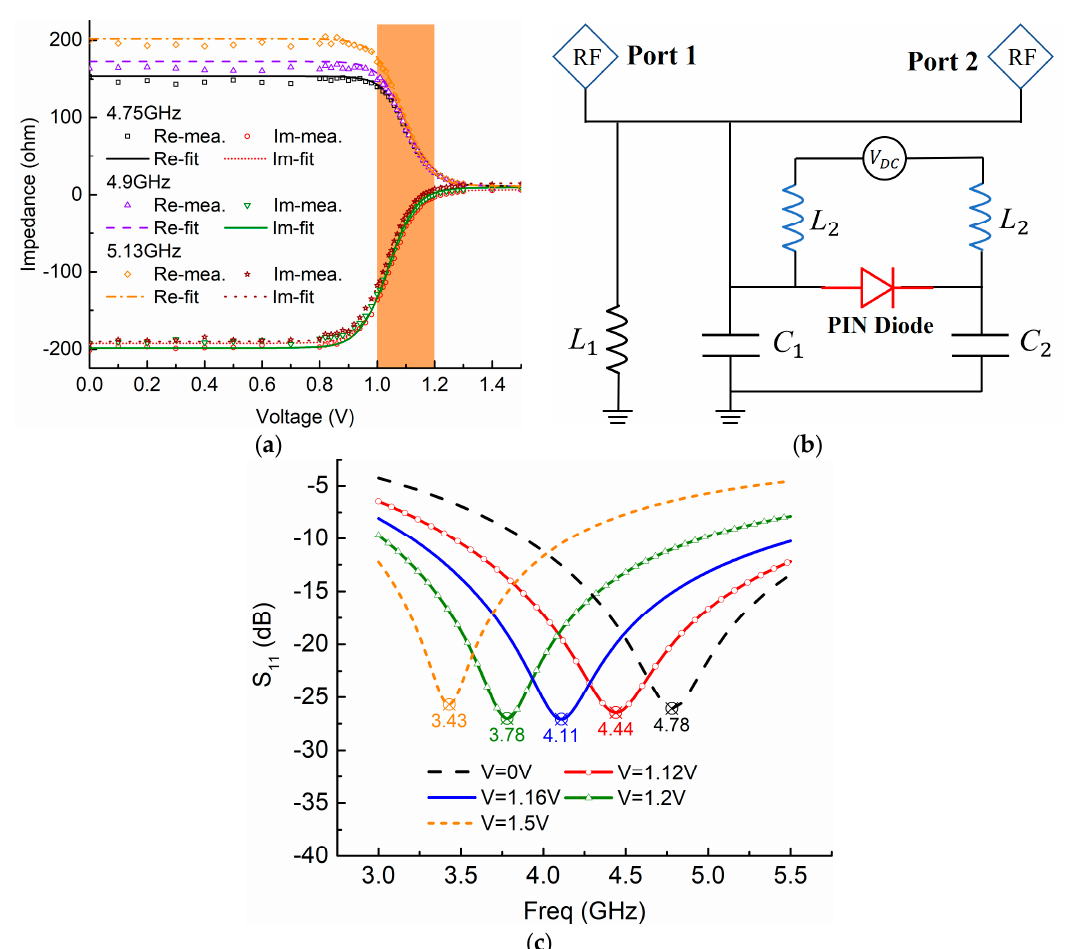
Figure 3. ( a ) Comparisons between fitting results by using the Boltzmann function and measured results; ( b ) the circuit contains parallel LC and PIN diode A (MACOM MA4AGBLP912) model, thereby implementing the proof-of-concept simulation to prove ( c ) continuous and smooth resonance tuning without blindness.